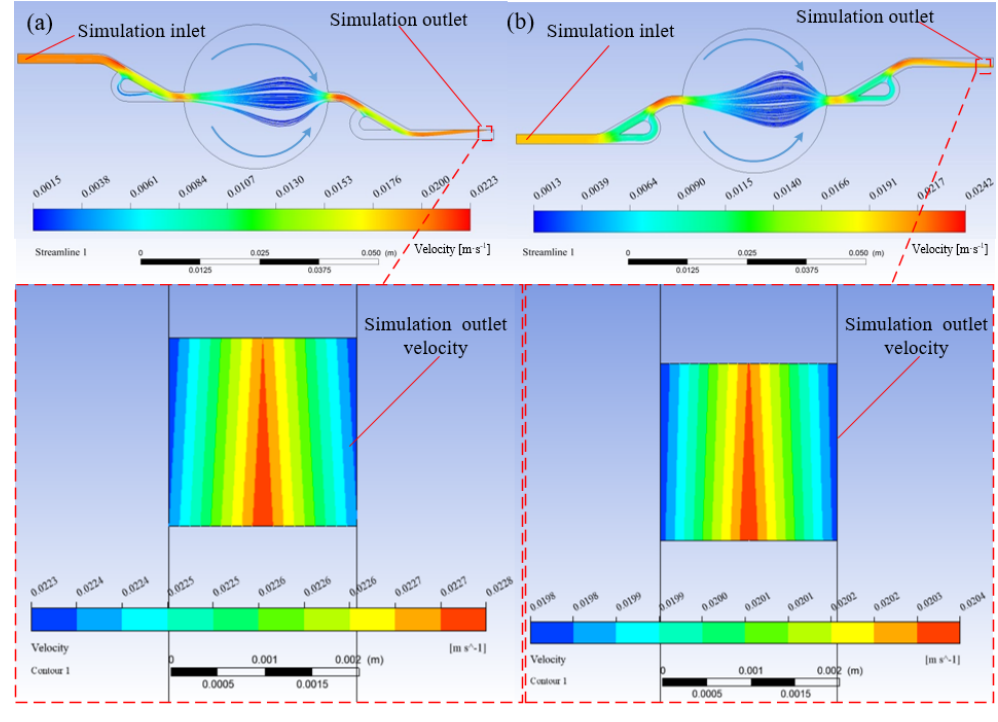
Figure 5. The forward and reverse flow simulation diagram of the optimal structure: ( a ) The forward velocity streamlines. ( b ) The reverse velocity streamlines.